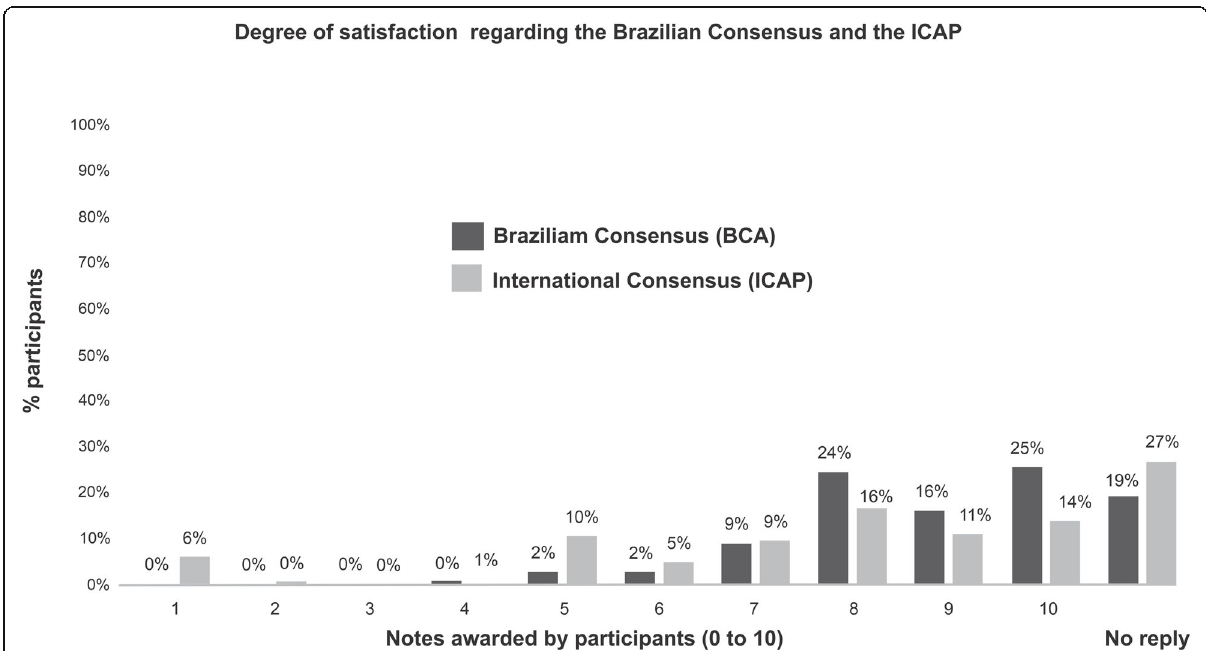
Fig. 2 Degree of satisfaction attribute of rheumatologist regarding the contributions of the Brazilian Consensus and the ICAP to clinical